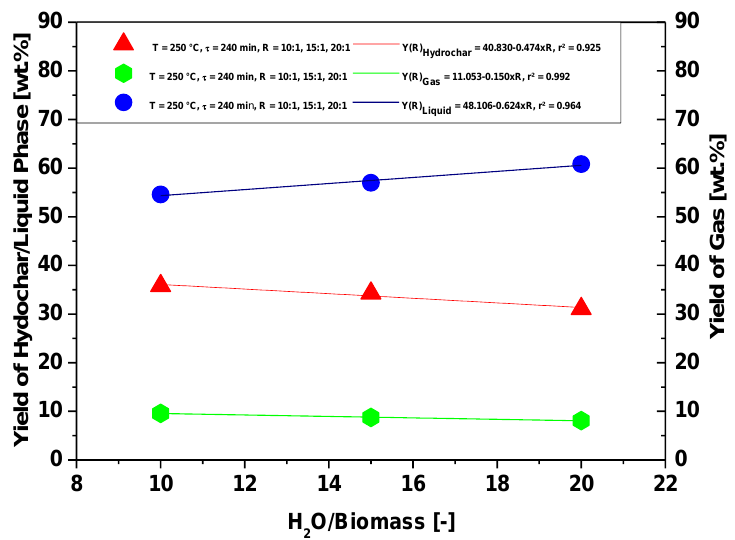
Figure 15. Yield of reaction products (hydro-char, aqueous phase and gas) by the hydrothermal processing of corn stover at 250 °C after 240 min with H 2 O-to-biomass ratios of 10, 15 and 20 using a reactor of 18.75 L.